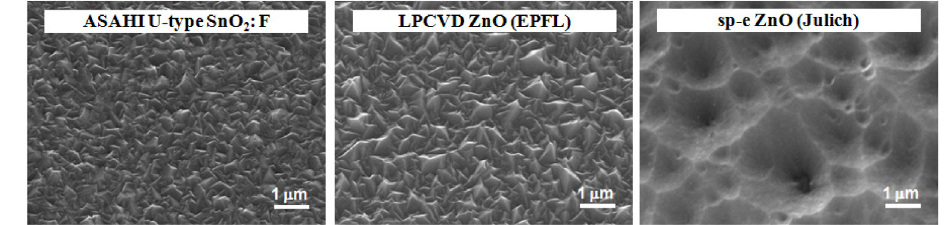
Fig. 1. Scanning electron microscope (SEM) images of textured TCO substrates used in this study (top view under an angle of 30 ◦ ).